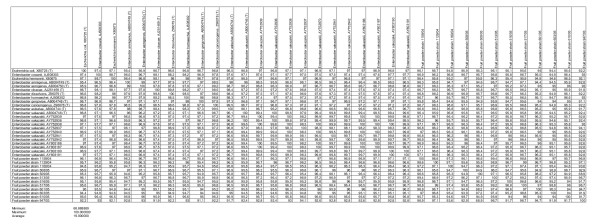
Respective distances matrix calculated with the sequences from figure 3.